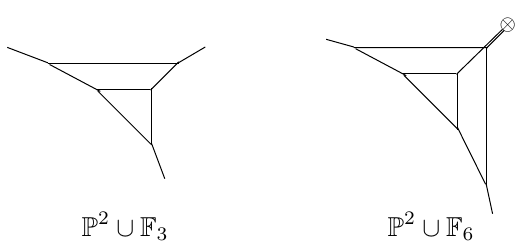
Figure 7. Brane con(cid:12)gurations of rank 2 SCFTs with zero